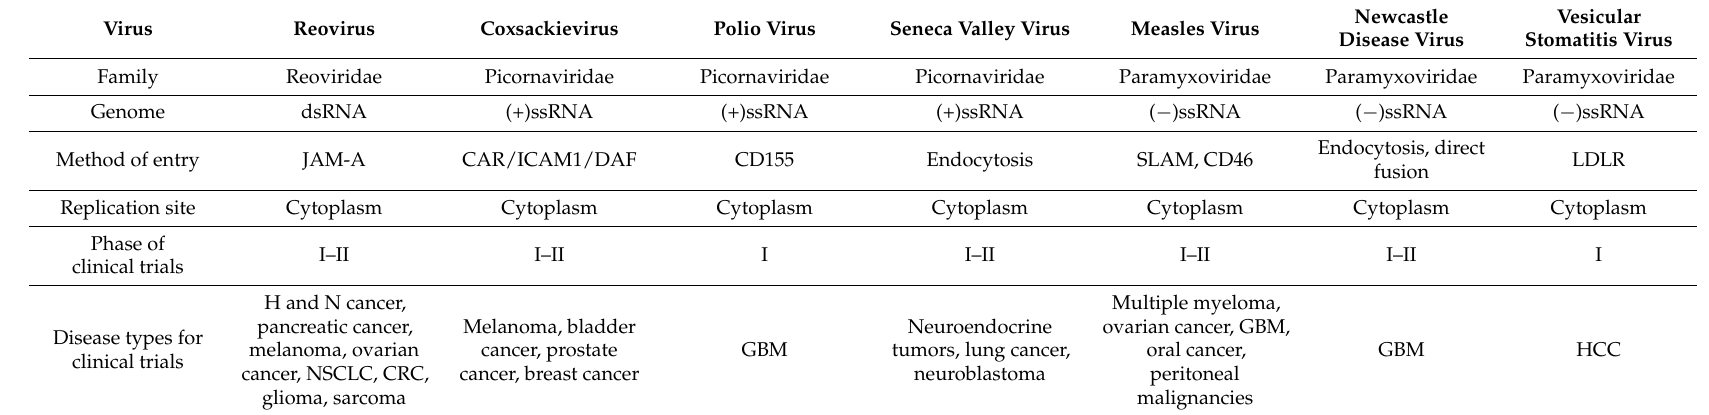
Table 2. Features of selected RNA oncolytic